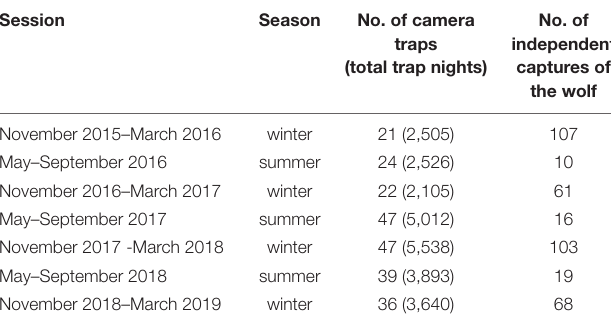
TABLE 1 | Summary of seven camera trapping sessions (2015–2019), conducted in the Nelang valley of the Gangotri National Park, Uttarakhand, India: the year of the survey, season, number of camera stations with a number of trap nights, number of the photographs of the independent wolves (multiple captures of the same individual within 30 min at a camera site were